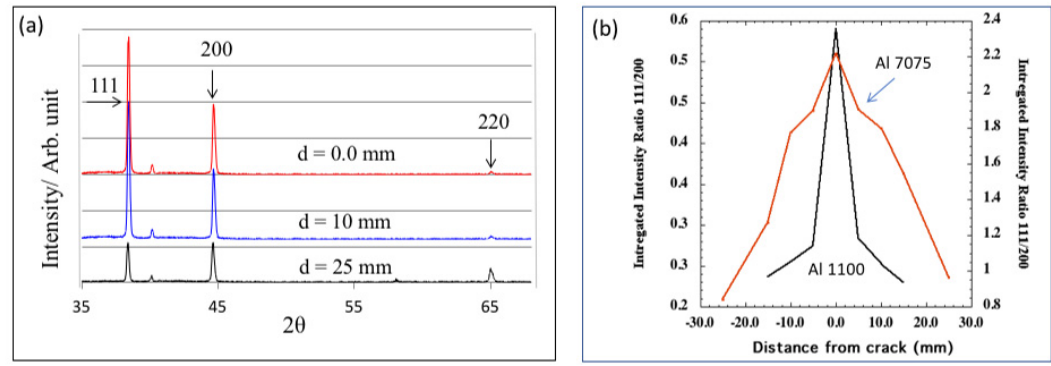
Figure 10. ( a ) X-ray diffraction (XRD) patterns as a function of distance from the crack showing the relative variations of intensity of 111 and 200 peaks. ( b ) The integrated intensity ratio of 111 to 200 as a function of position from crack for Al 1100 and Al 7075. The y-axis values for Al 7075 are shown on the right